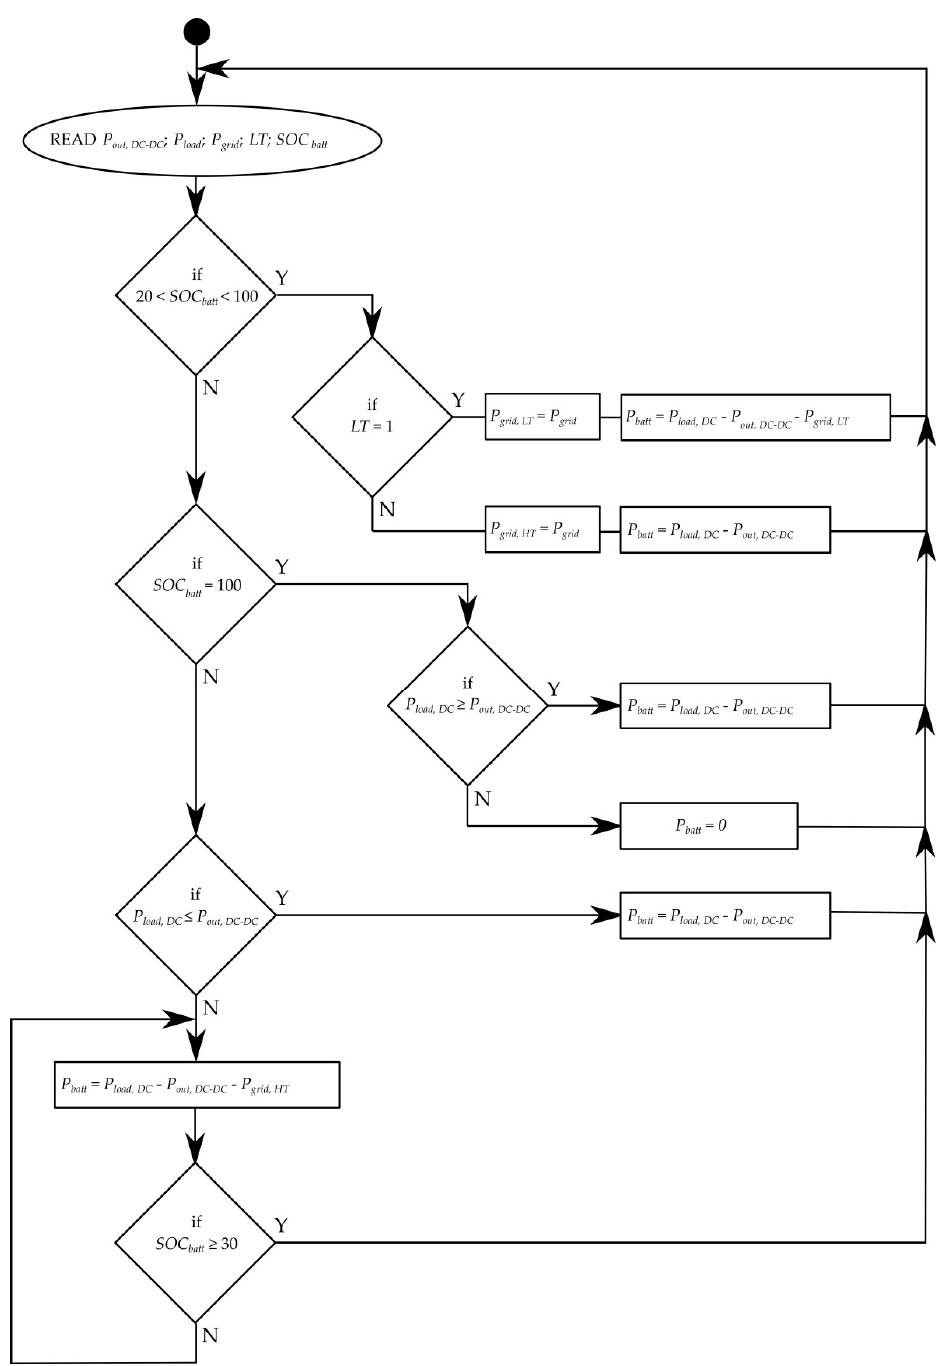
Figure 9. Control algorithm for charging up supporting storage.